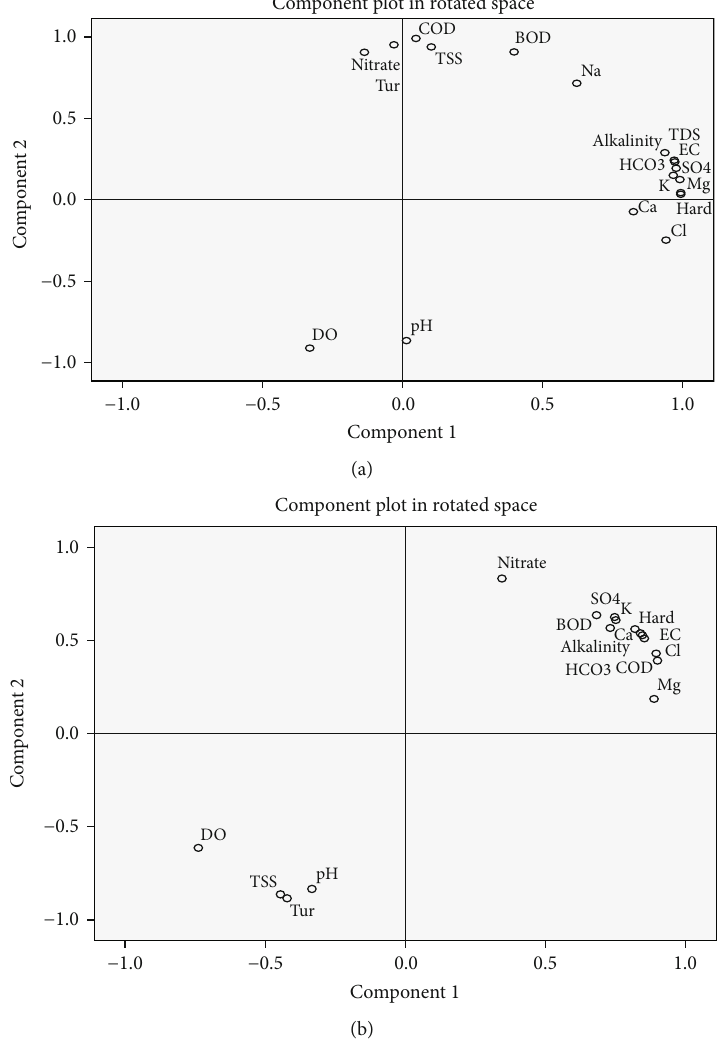
Figure 5: (a) PCA plotting for premonsoon season; (b) PCA plotting for postmonsoon